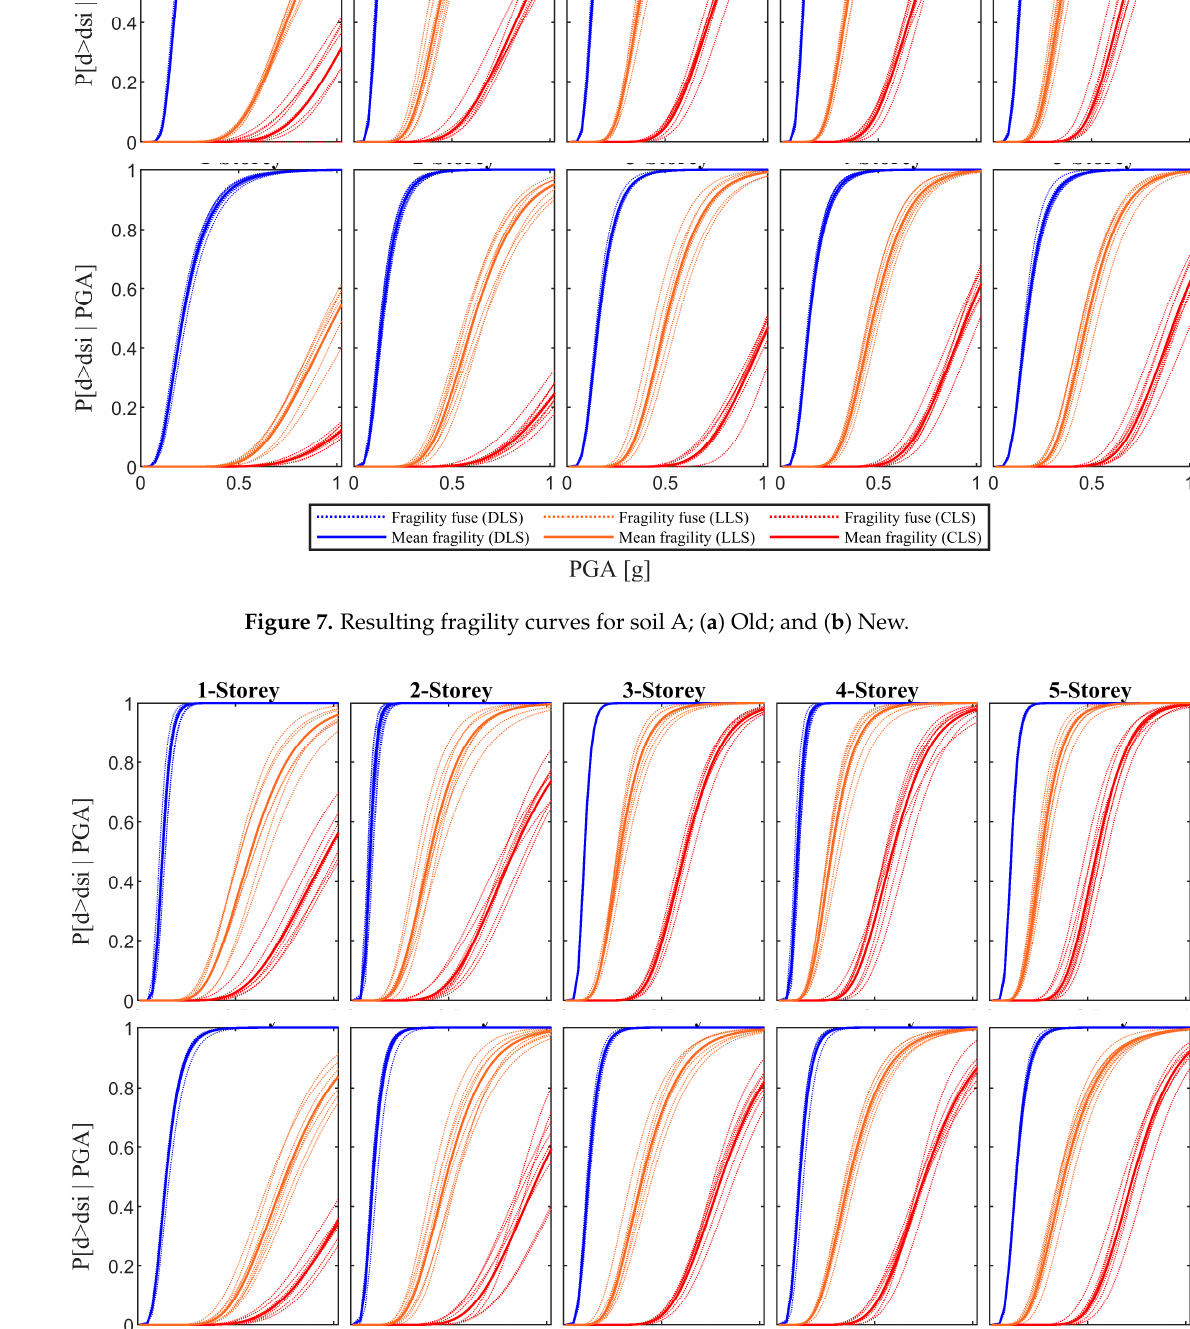
Figure 8. Resulting fragility curves for soil C; ( a ) Old; and ( b ) New.